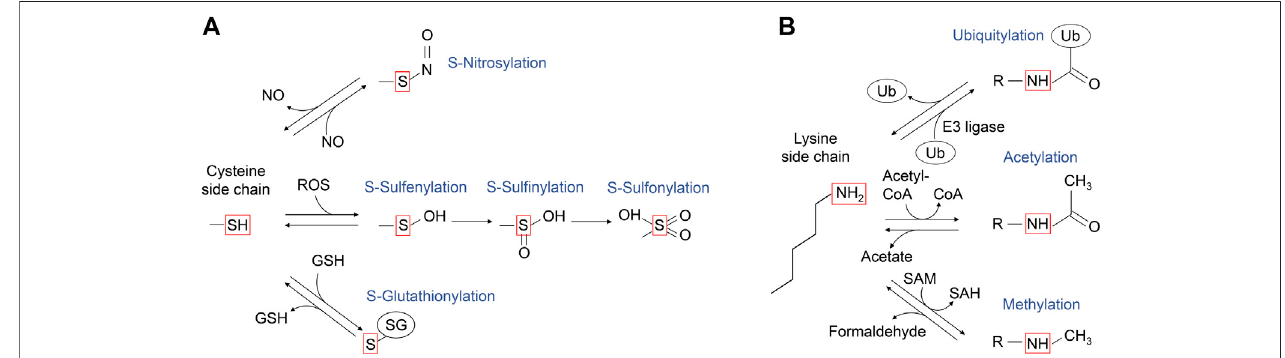
FIGURE 4 | A schematic diagram of the post-translational modi fi cations of cysteine and lysine side chains. (A) The sulfur atom of cysteine side chain can undergo several oxidative modi fi cations, including those shown in the red box. S-nitrosylation can be generated upon reaction with nitric oxide (NO). Upon the reaction with reactive oxygen species (ROS), the sulfur atom of cysteine side chain can undergo S-sulfenylation, and further oxidation to S-sul fi nic and S-sulfonic states. The cysteine side chain can also form mixed disul fi des, including reaction with glutathione (GSH) to undergo reversible S-glutathionylation. (B) The ε -amino group of lysine side chain can undergo several modi fi cations as shown in the red box. The portion of modi fi ed lysine side chains is shown as “ R-NH ” . Ubiquitylation is mediated by ubiquitin E3 ligase, while deubiquitylation is mediated by deubiquitylases. Lysine acetyltransferases use acetyl-CoA as the acetyl-donor for lysine acetylation, which can be reversed by acetylated lysine deacetylases. Lysine methyltransferases use S-adenosylmethionine as a methyl donor for lysine methylation, which is reversed by methylated lysine demethylase, coproducing